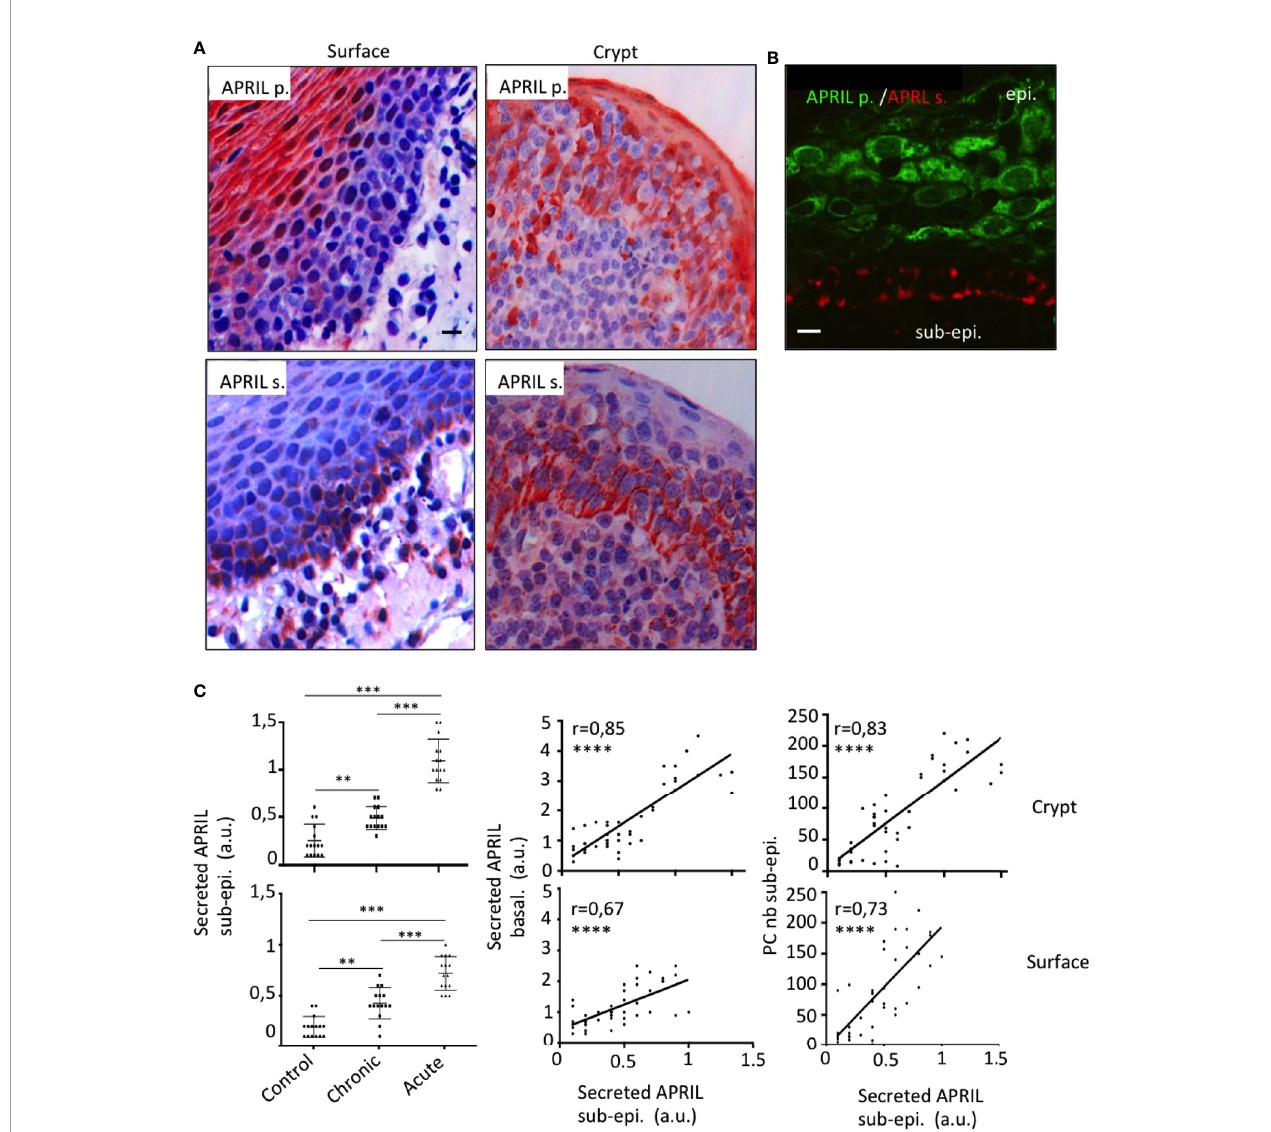
FIGURE 1 | Production and storage sites for APRIL are distant in the tonsil epithelium. (A) Serial sections of tonsils were stained for APRIL production (APRIL p.) and secreted APRIL (APRIL s.). Scale bar = 10 µm. (B) Costaining for APRIL p. (green) and APRIL s. (red) on the same section is shown. Scale bar = 5 µm. The epithelium (epi.) and sub-epithelium (sub-epi.) are marked. Results are representative of more than 15 tonsillectomies for patients with chronic infections. (C) Staining quanti fi cation for 15 control, 15 chronically infected, and 15 acutely infected tonsils is shown for secreted APRIL in the sub-epithelial area (left panel). A one-way unpaired parametric ANOVA test was performed. Correlations with the staining intensity obtained in the basal layer of the epithelium (middle panel) and density of PCs in the area (right panel) are also shown. A Pearson ’ s correlation t test was performed. **p < 0.01, ***p < 0.001, ****p <